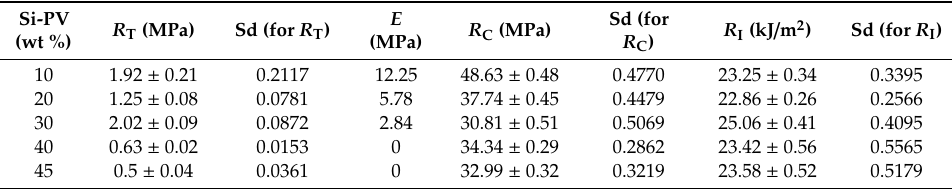
Table 6. Mechanical tests results of increased all Si-PV content